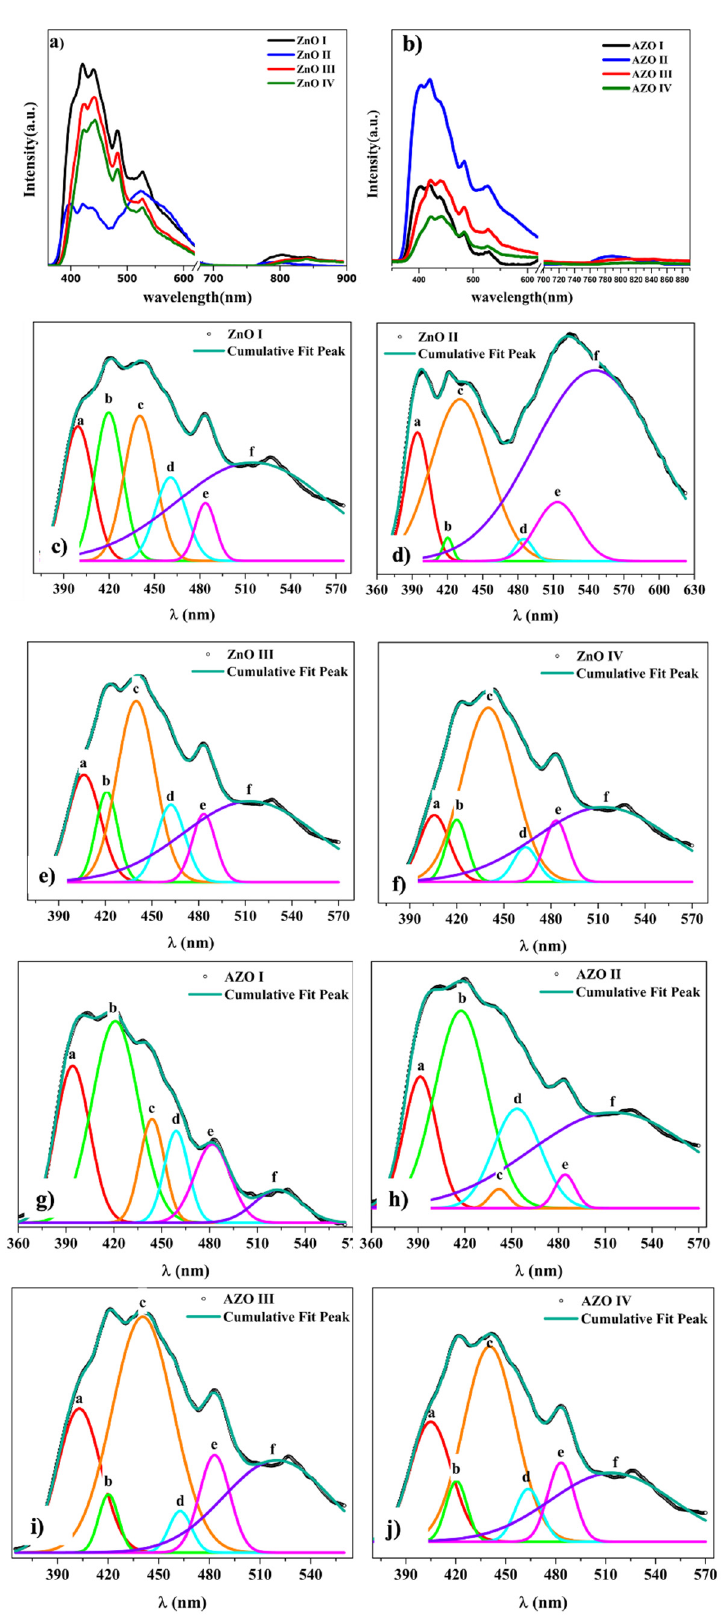
Figure 9. ( a , b ) Room temperature PL spectra and ( c – j ) PL deconvolution in the visible range of nanostructured ZnO and AZO samples.